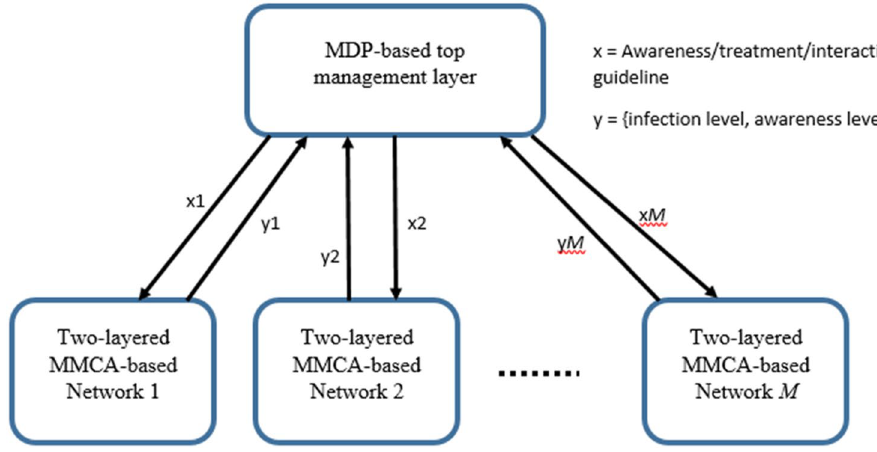
Fig. 1 Multi-layered model